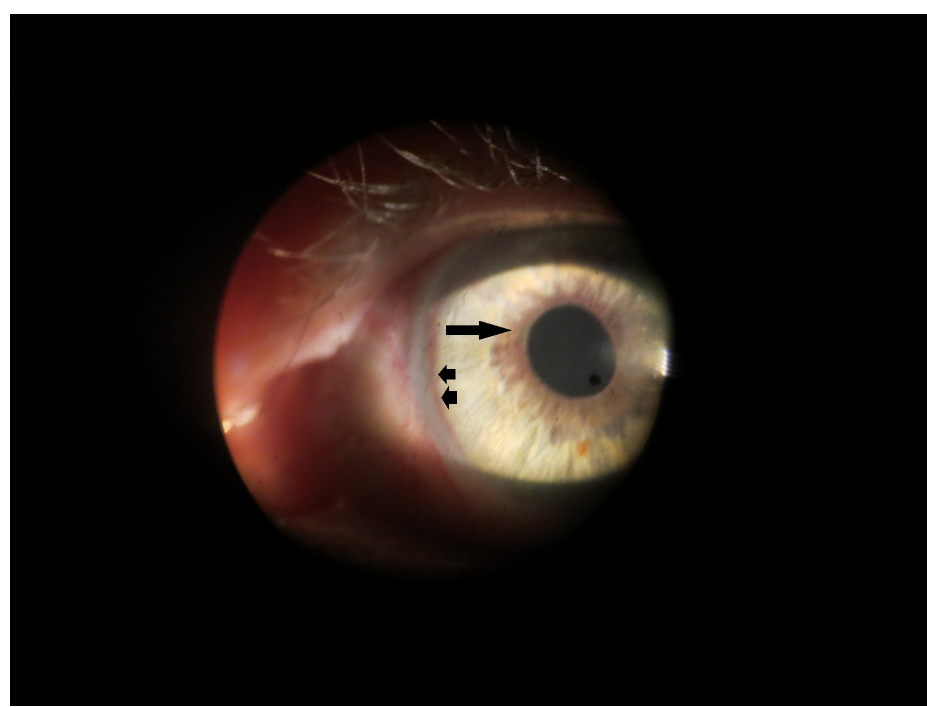
Figure 1: Slit lamp biomicroscopy of the anterior segment of the left eye shows marginal (arrow) and peripheral (arrowheads) circumferential neovascularization of the iris.